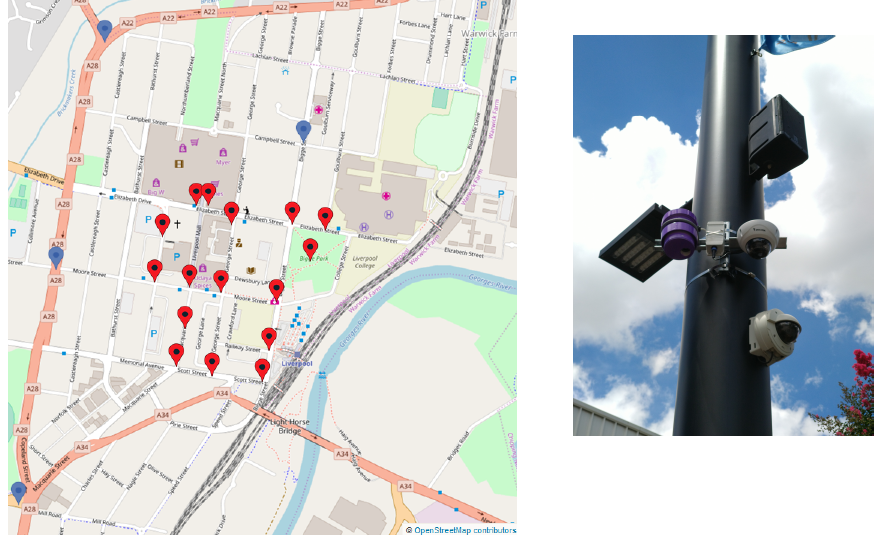
Figure 1. A map of the town center. ( left ) Locations of the 20 visual sensors. It is expected that the live data produced from those location will help urban planners to update the city’s mobility plan. ( right ) Co-location of two CCTV cameras and an air quality (in purple) on a